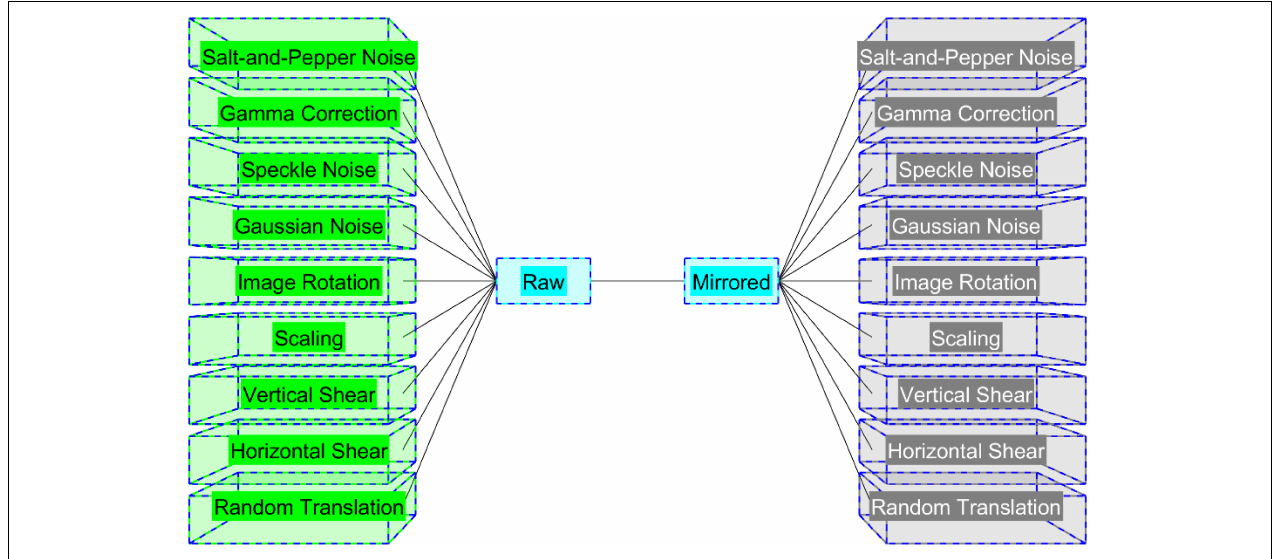
FIGURE 9 | Diagram of multiple-way data augmentation.